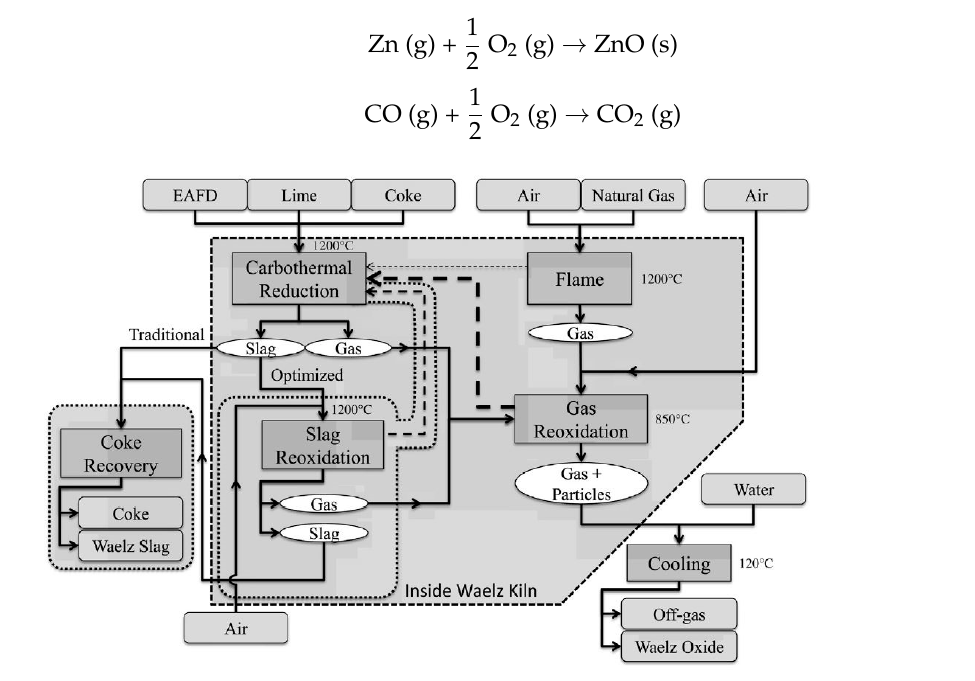
Figure 1. Schema of Waelz process [18].